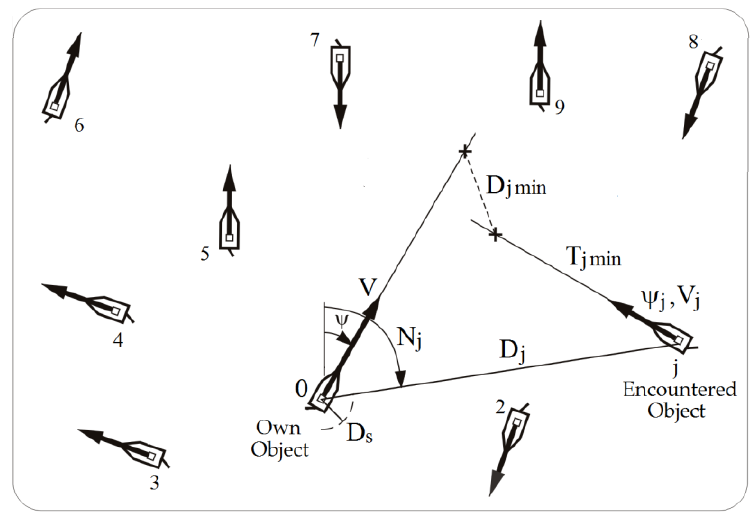
Figure 1. The navigational situation of the passage of the own object 0 moving at speed V and course ψ with the j th object encountered when moving at speed V j and course ψ j . In this figure, D j is distance, N j is bearing and D s is safe distance.